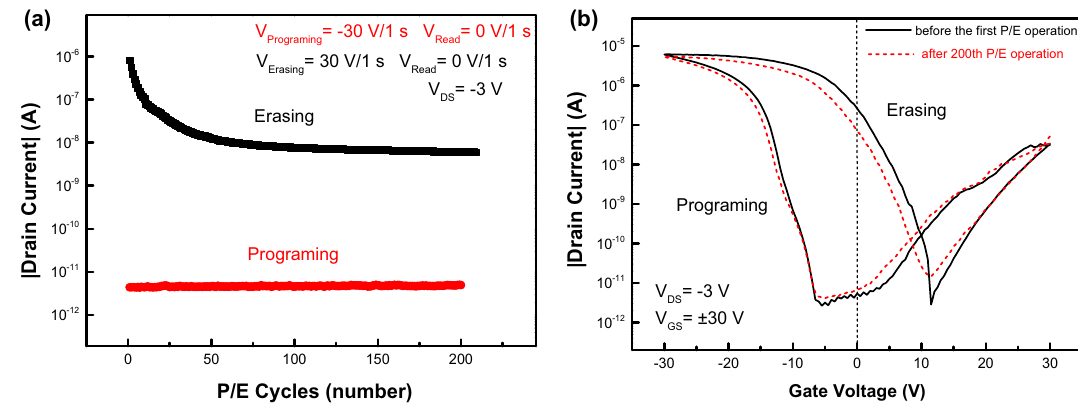
Figure 4. ( a ) The endurance characteristics of pentacene OFETs with a 20-nm-ZnO interlayer, ( b ) the transfer characteristics of the OFET before the first P/E operation and after the 200th P/E